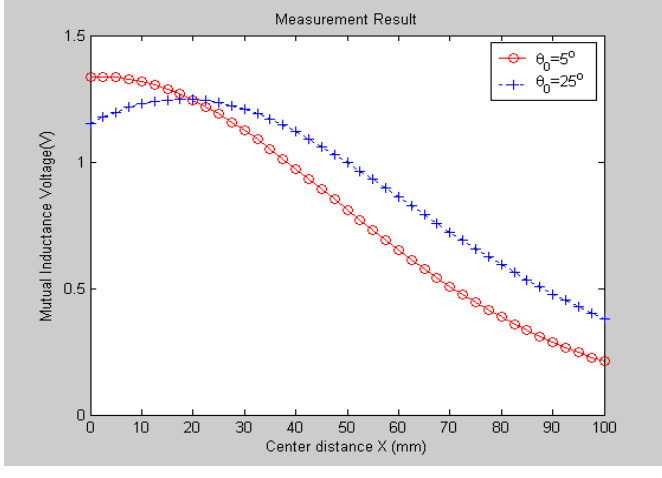
Figure 6. 2-D graphs of ( a ) measured mutual inductance voltage; ( b ) NIELA -based mutual inductance; ( c ) EELA -based mutual inductance versus center distance between Solenoid I and II ( Z = 115